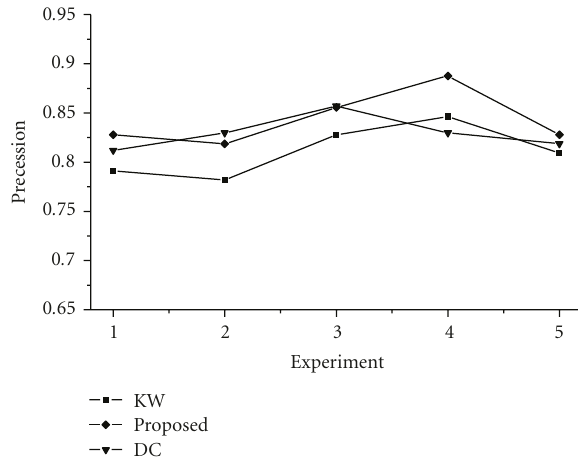
Figure 13: Precision of detected moving edges by di ff erent methods.